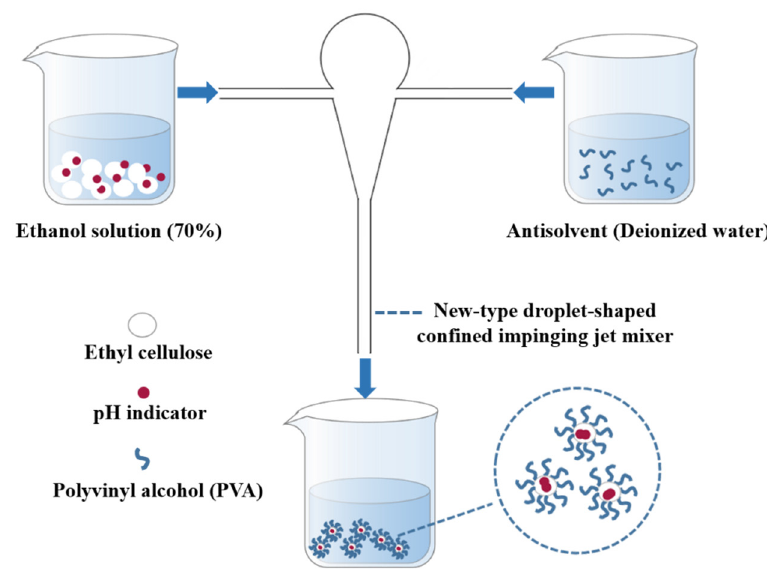
Figure 1. Schematic diagram showing the preparation of nanocapsules.